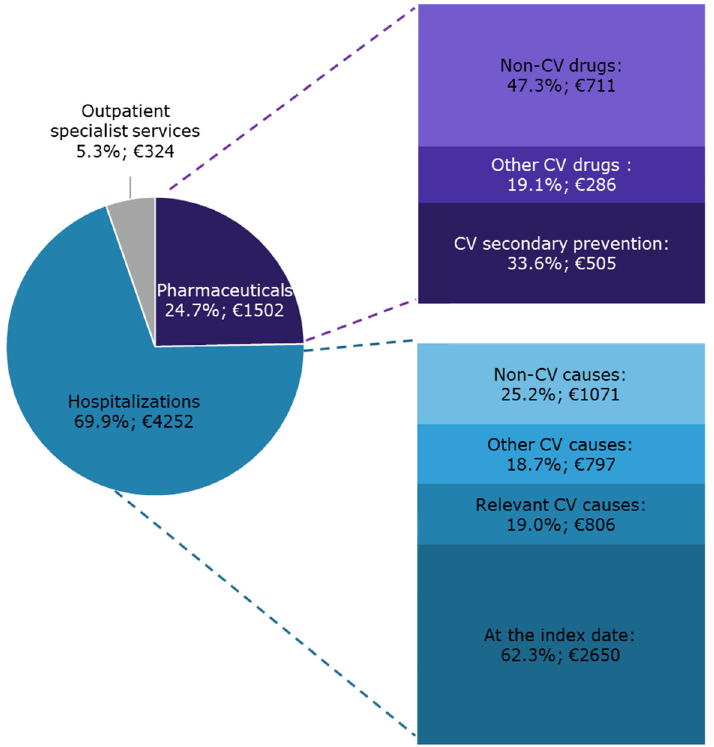
Figure 3. The INHS healthcare costs of patients with CAD and eligible for CV secondary preventive treatments during one-year follow-up are shown as the distribution of the specific cost items and as mean expenditure per capita (€).